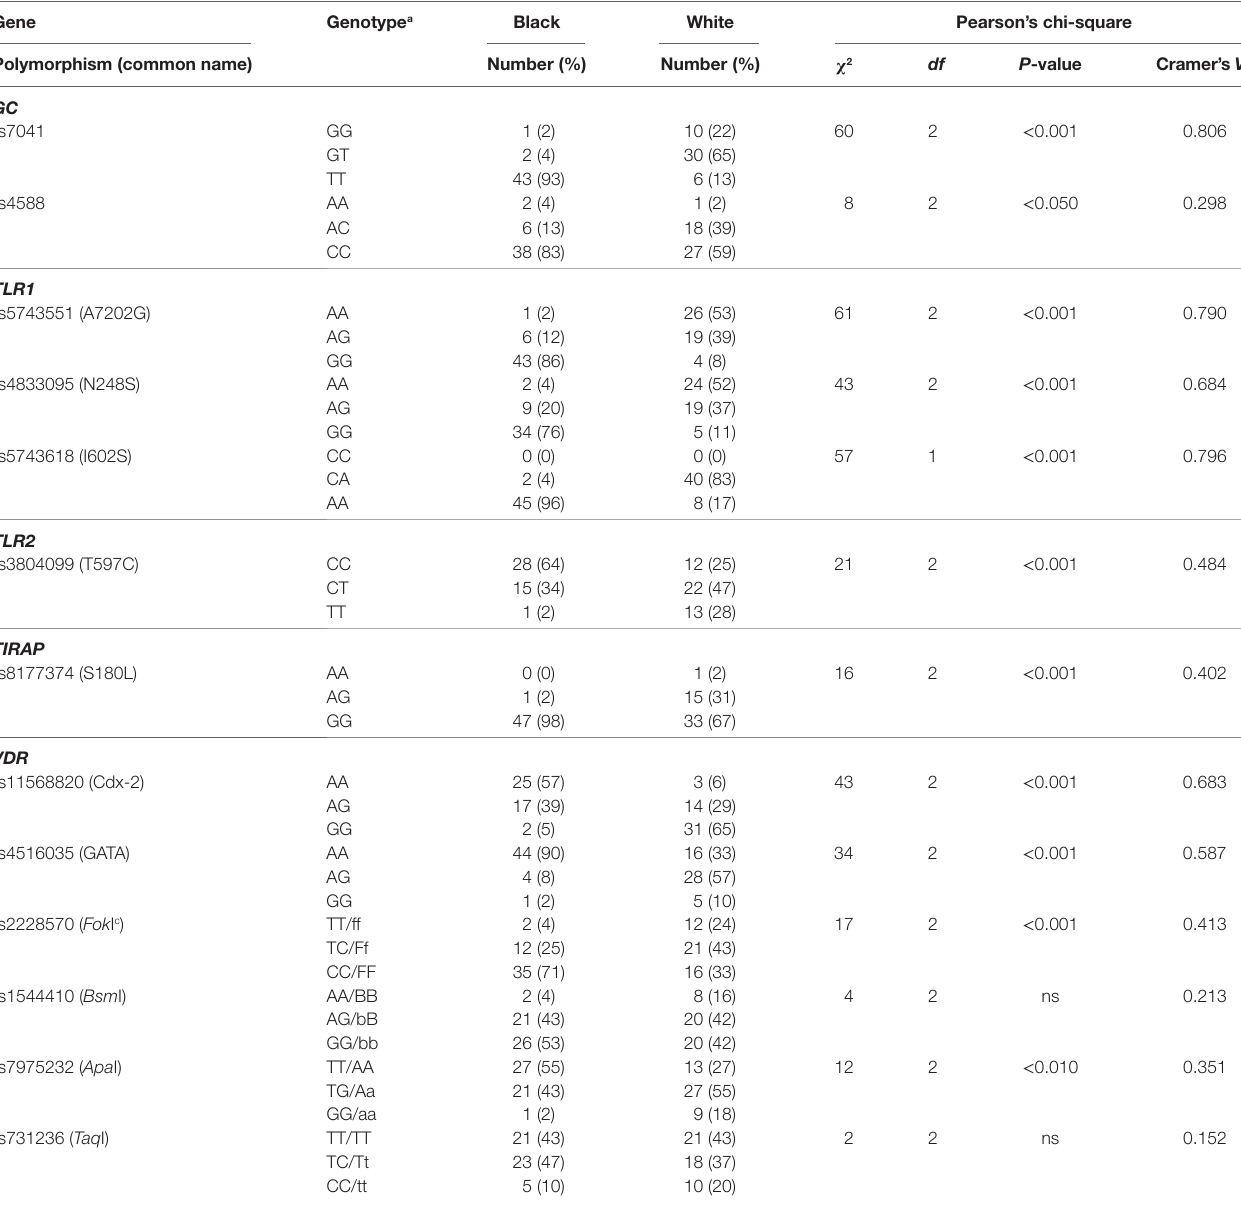
TaBle 1 | Differential genotype distribution for polymorphic single-nucleotide polymorphism (SNPs) in the toll-like receptor (TLR)–vitamin D receptor (VDR) pathway in Black and White South Africans. gene genotype a Black White Pearson’s chi-square Polymorphism (common